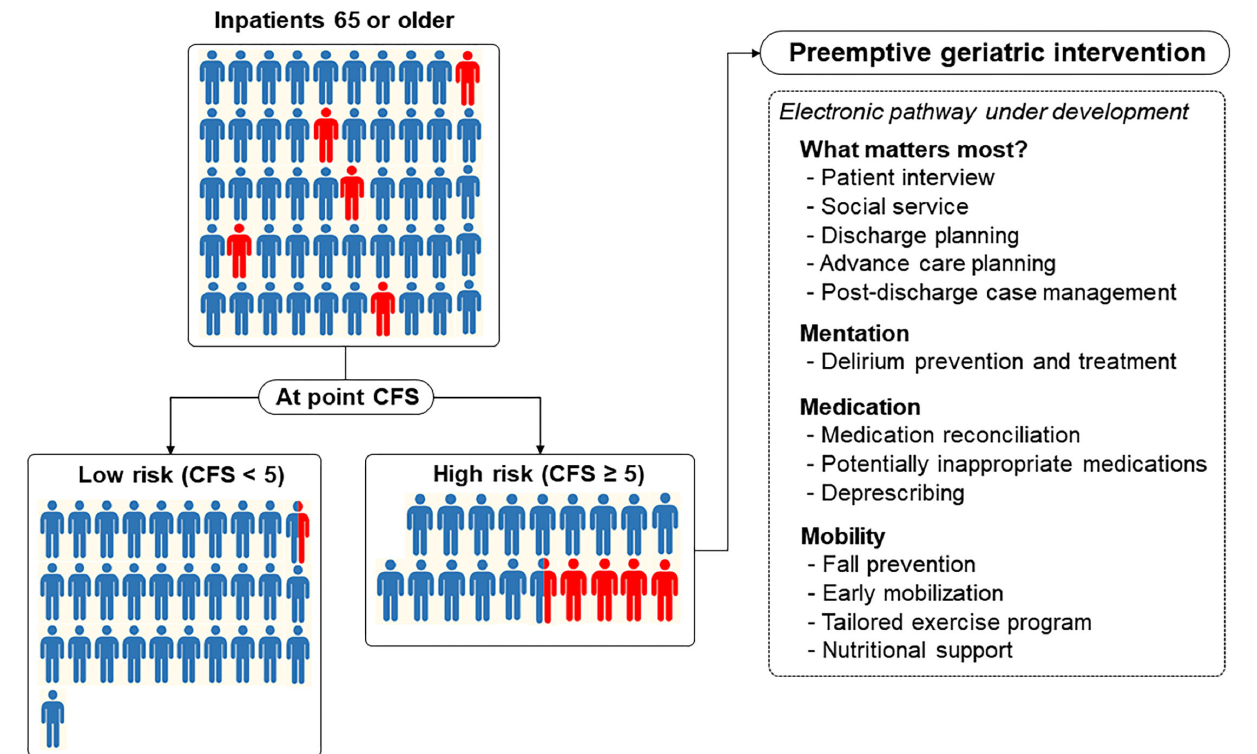
FIGURE 3 | Acute electronic frailty pathway under development using the Clinical Frailty Scale (CFS) as a universal risk indicator for older inpatients to provide a preemptive geriatric intervention encompassing domains of an age-friendly health system. In this figure, a red-colored human denotes a person (1 person denotes 2% incidence) who developed the composite outcome and is shown to reflect the distribution of the CFS and prevalence of the composite outcome in our